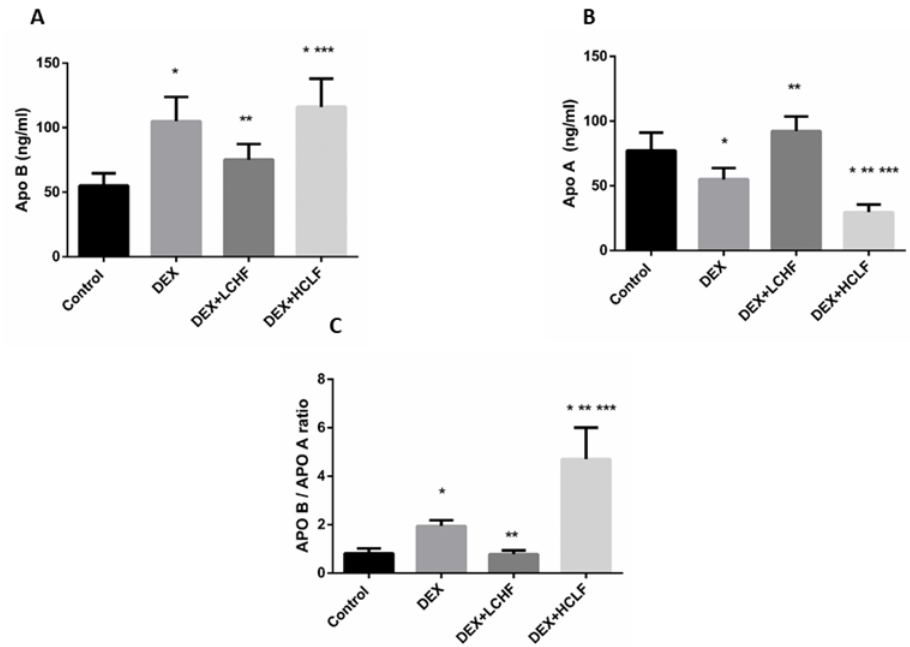
Figure 7. The impact of low-carbohydrate high-fat diet, and high-carbohydrate low-fat diet on APO B: ( A ) Apo A1 ( B ), and the APO B/ APO A1 ratio ( C ) in dexamethasone-treated rats. DEX: rats